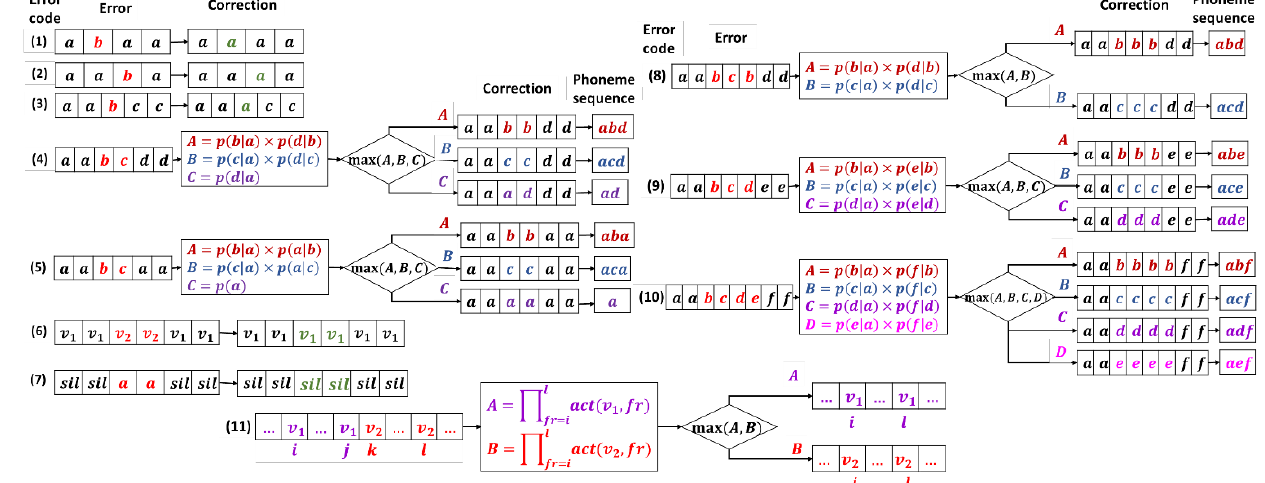
Figure 2. Steps of post-processing method: error codes, error types, and error correction